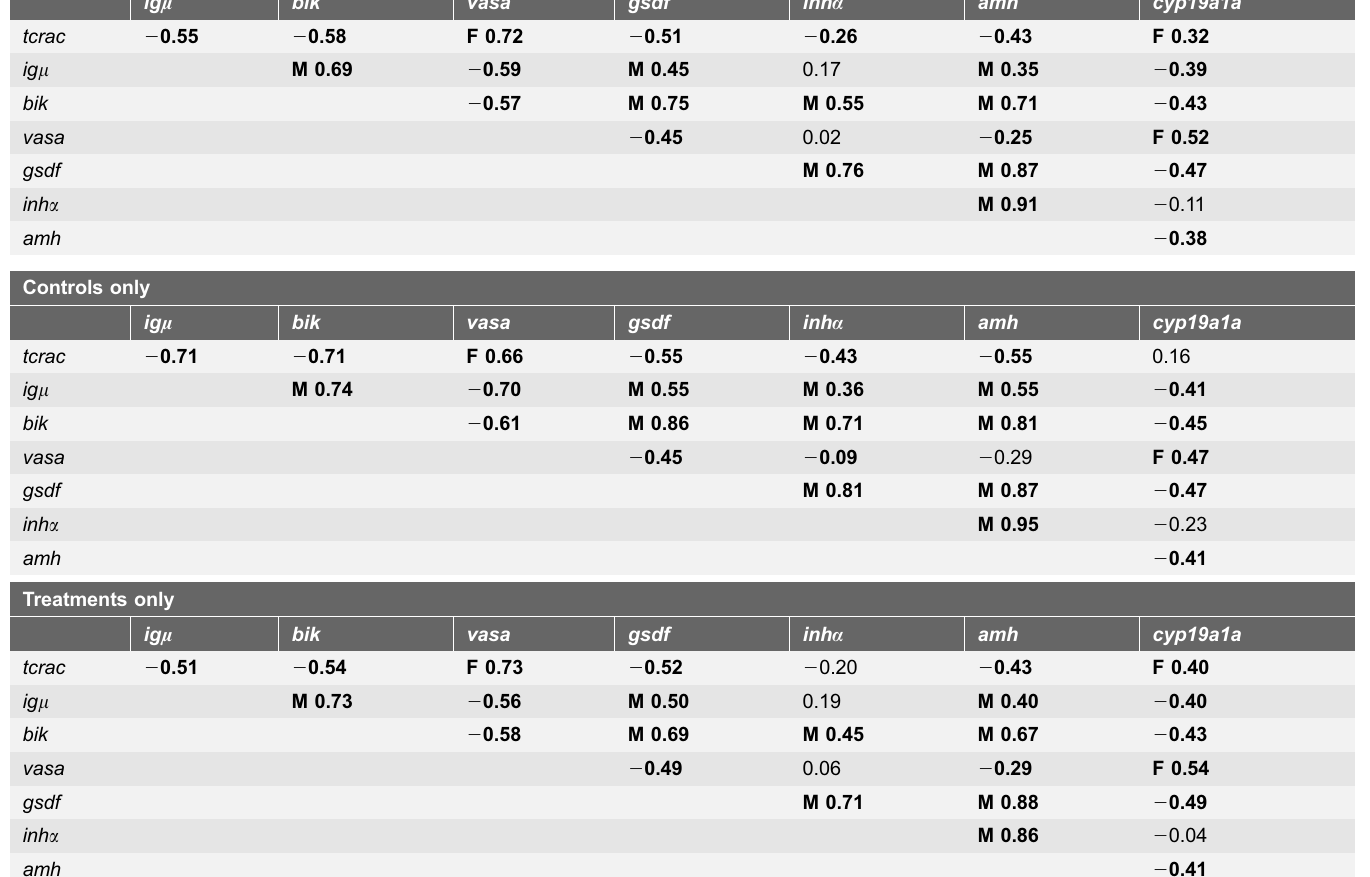
The pattern of correlations is similar in controls (n 5 32) and in the treated groups (n 5 77). Significant r -values ( p , 0.05) are marked with bold font. Significant correlations among male-enriched and female-enriched transcripts are denoted with M or F letters,